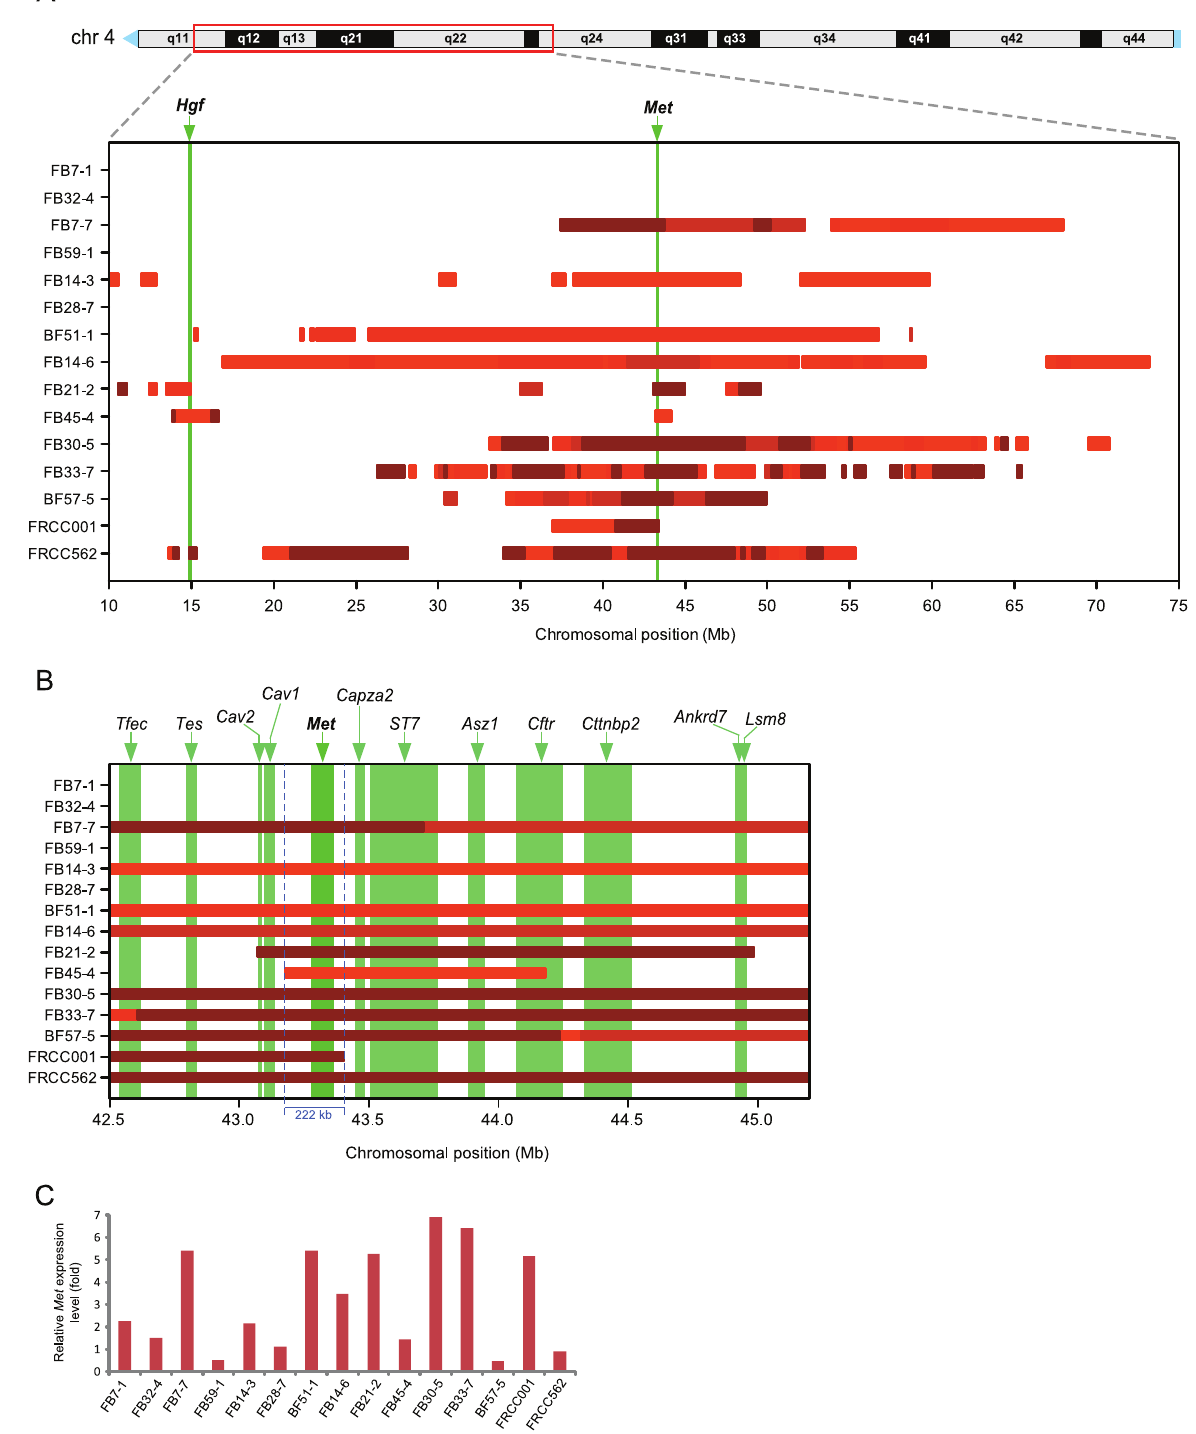
Figure 3. Frequent wide-ranging amplifications over a long pericentromeric region of chromosome 4 with the Met oncogene residing in the most overlapping section. (A) The bar chart represents the amplification regions along a 65 Mb pericentrometic region of chromosome 4 for 13 RCC tumors and two RCC cell lines. Four grades of amplification are indicated by bar color gradation; the darker the red, the larger the amplitude. (B) A magnified view of the bar chart above shows the vicinity of the most overlapping region. The genomic regions of all of the RefSeq genes included in the displayed range of the chromosome are depicted as vertical bars in the background. (C) Expression analysis of Met for 13 RCC tumors and two RCC cell lines by real-time PCR. The values on the y -axis indicate relative mRNA expression level compared to an average of those in normal kidneys of three control rats.